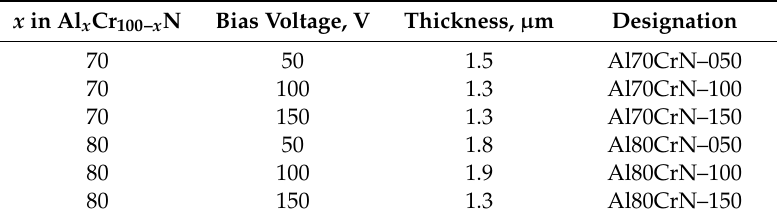
Table 1. Overview of AlCrN variants